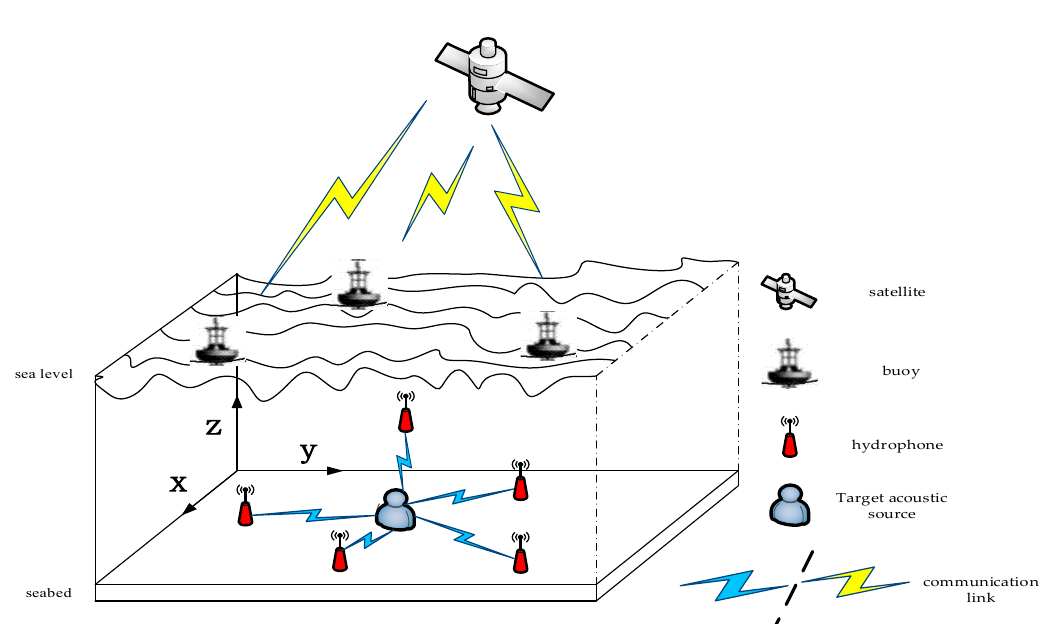
Figure 1. 3-dimension model for the underwater acoustic sensor networks (UASNs). Each hydrophone receives the signal from the targeted acoustic source.